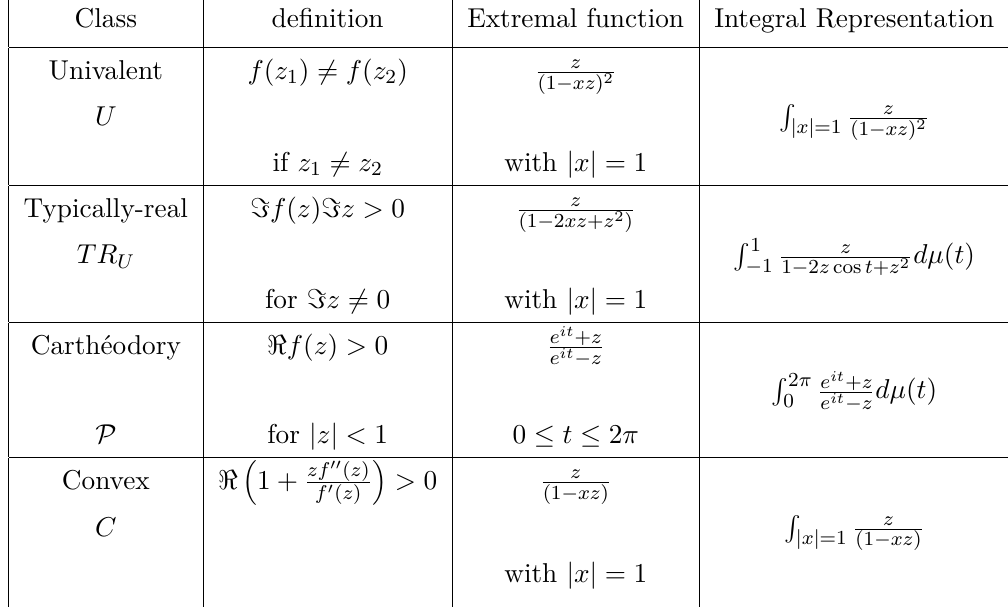
Table 3. Extremal functions for various classes inside the unit disk | z | < 1